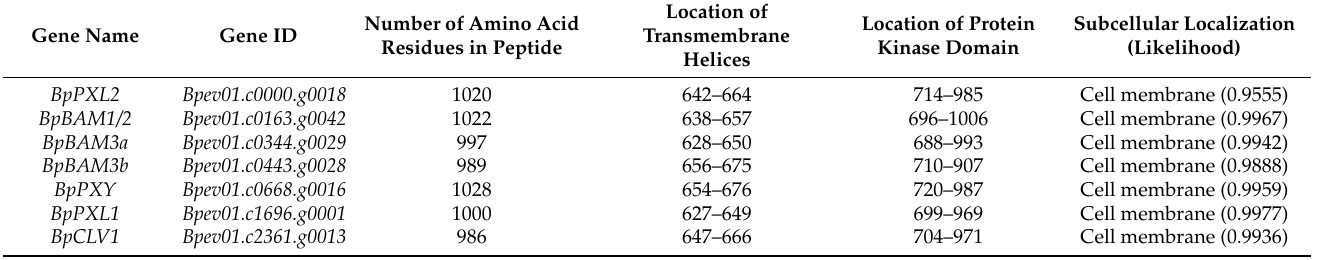
Table 3. The features of the B. pendula subgroup XI receptor kinase-like (RLK) family members.